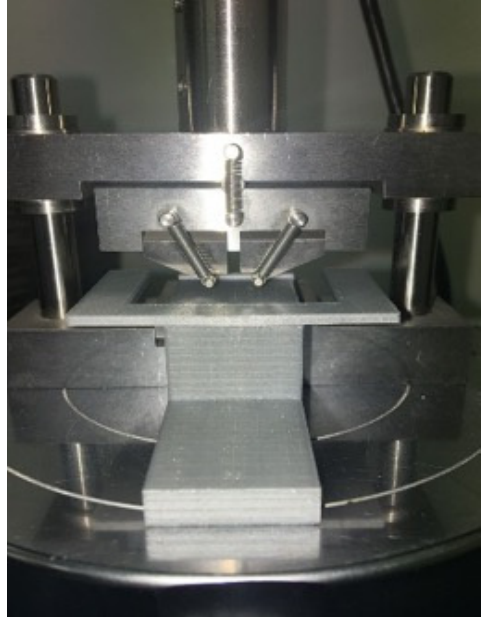
Figure 1. 3D printed alignment jig positioning the specimen in the centre of the four-point bending jig.